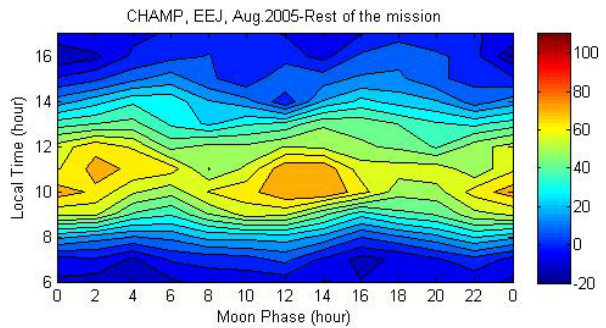
Fig. 6. The same as Fig. 1, but for the solar minimum years Aug. 2005-2010.